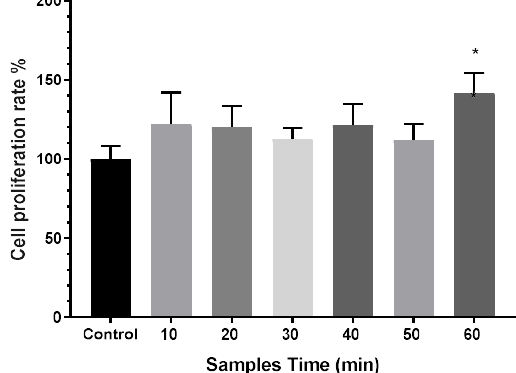
Figure 10. hFOB cell proliferation on samples modified at different times, as determined by mitochondrial activity. Results are the mean of four independent experiments performed in the DCD ± S.D. A one-way ANOVA was performed between the O.D. of each modified sample and the unmodified sample or control, where (*) ( p < 0.05).